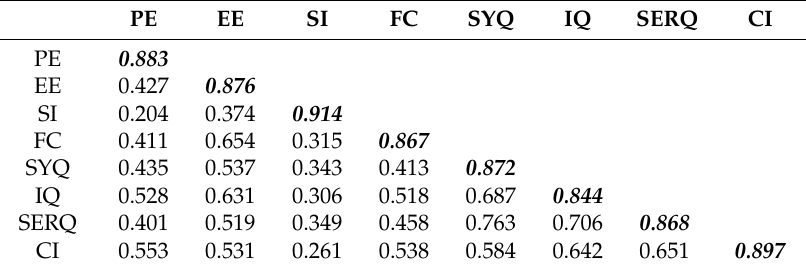
Table 3. Correlation matrix and discriminant validity.